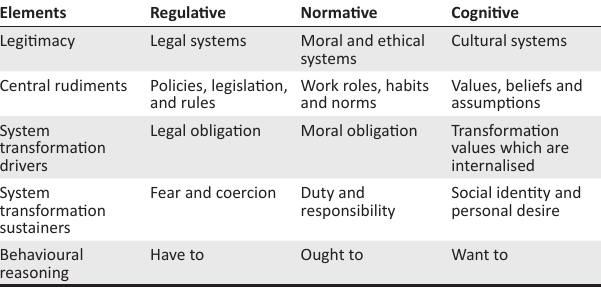
TABLE 1: Comparison between regulative, normative and cultural cognitive elements of institutional